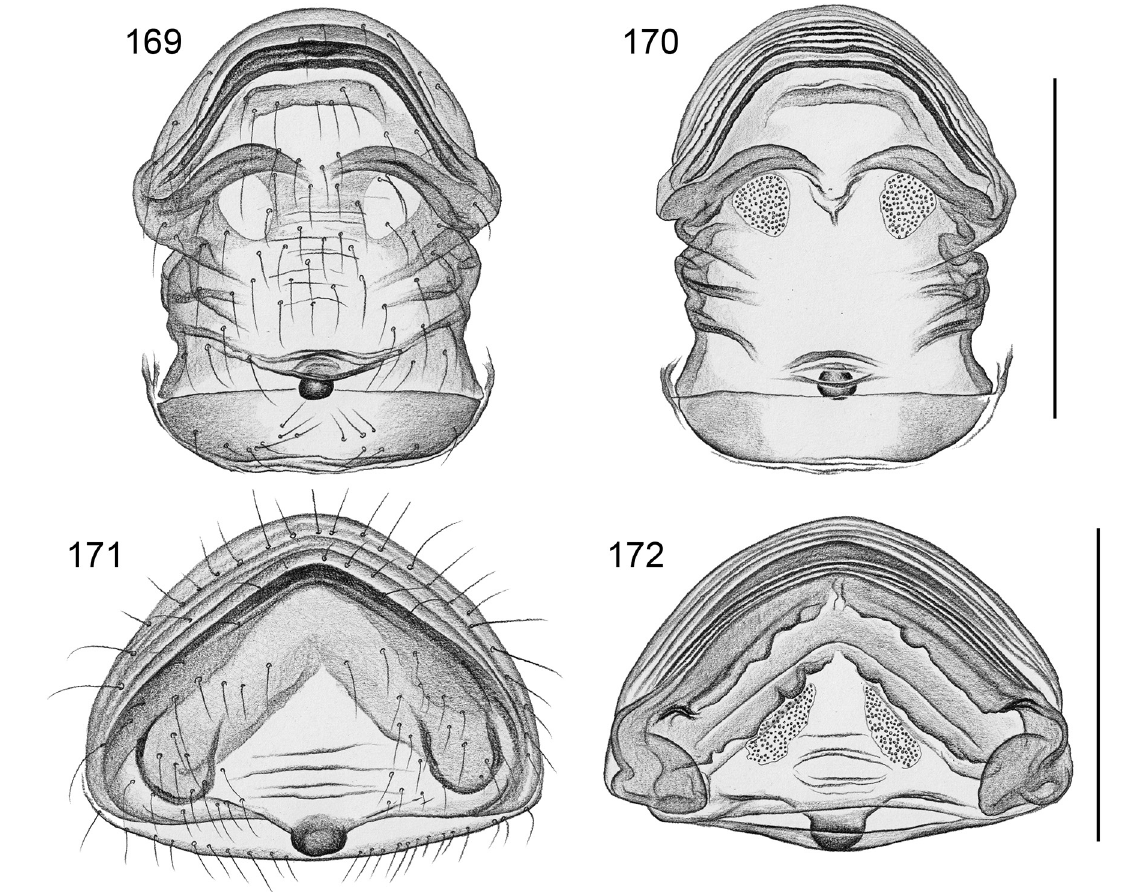
Figs 169–172. Cleared female genitalia, ventral and dorsal views. 169–170 . Pholcus satun Huber, 2011, ZFMK ‘Mal 328’. 171–172 . Ph. schwendingeri Huber, 2011, ZFMK Ar 15050. Scale lines: 0.5